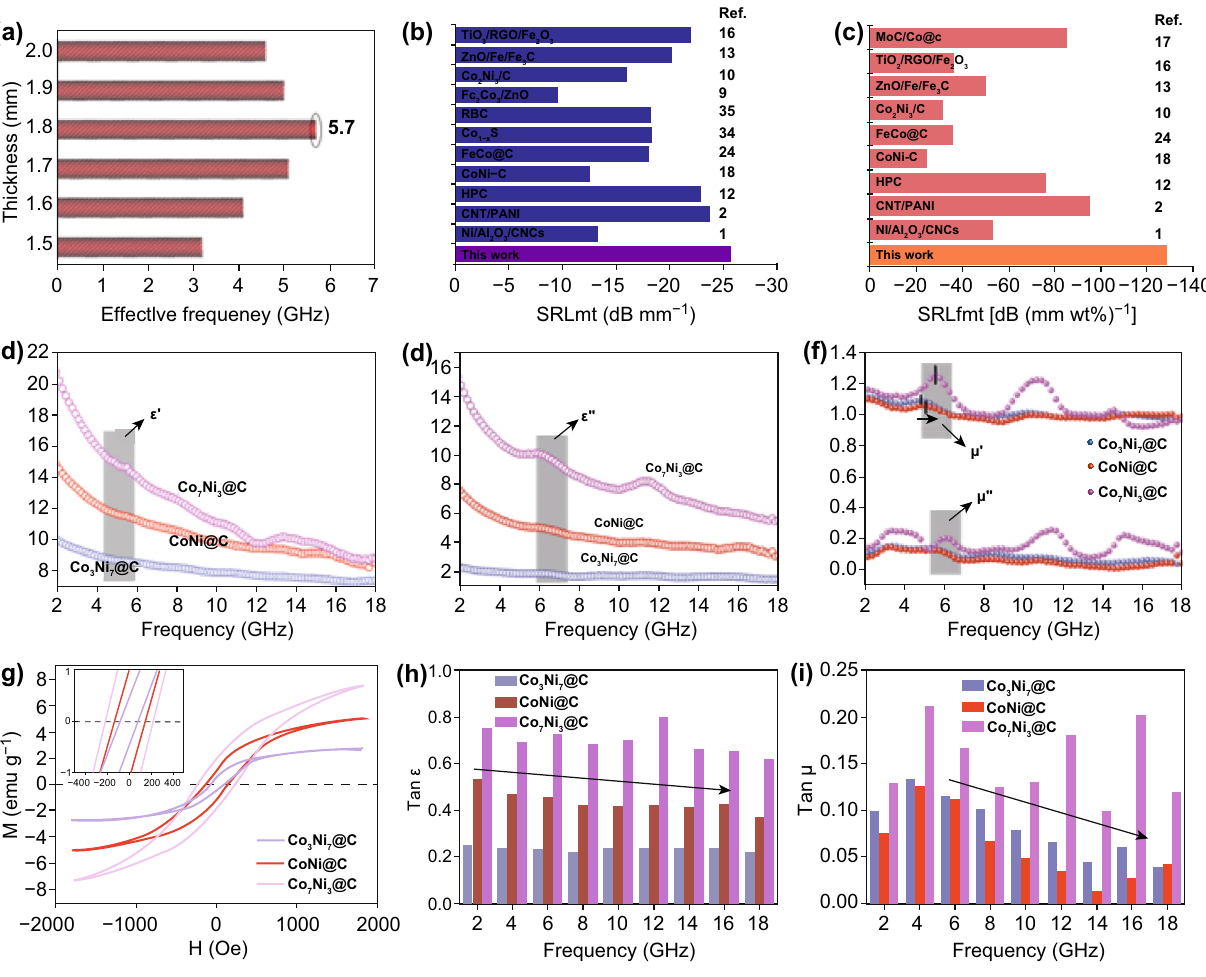
Fig. 4 a Effective frequency bandwidth of CoNi@C. b SRL mt and c SRL fmt of carbon-based materials. d Real part and e imaginary part of per- mittivity of Co x Ni y @C nanosheets. f Permeability of Co x Ni y @C nanosheets. g Magnetic hysteresis loops of Co x Ni y @C nanosheets. h Dielectric loss tangent and i magnetic loss tangent of Co x Ni y @C